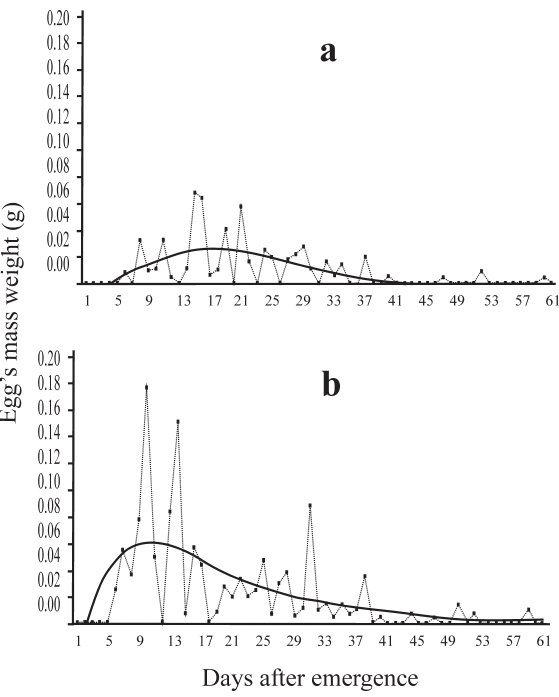
Figure 1 - a: Oviposition rhythm of Cochliomyia macellaria . b: Oviposition rhythm of Chrysomya